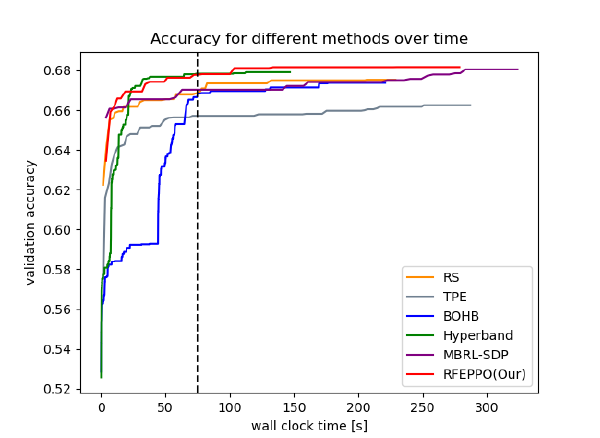
Figure 6. Average validation accuracy across five trials on the winequality_white dataset over